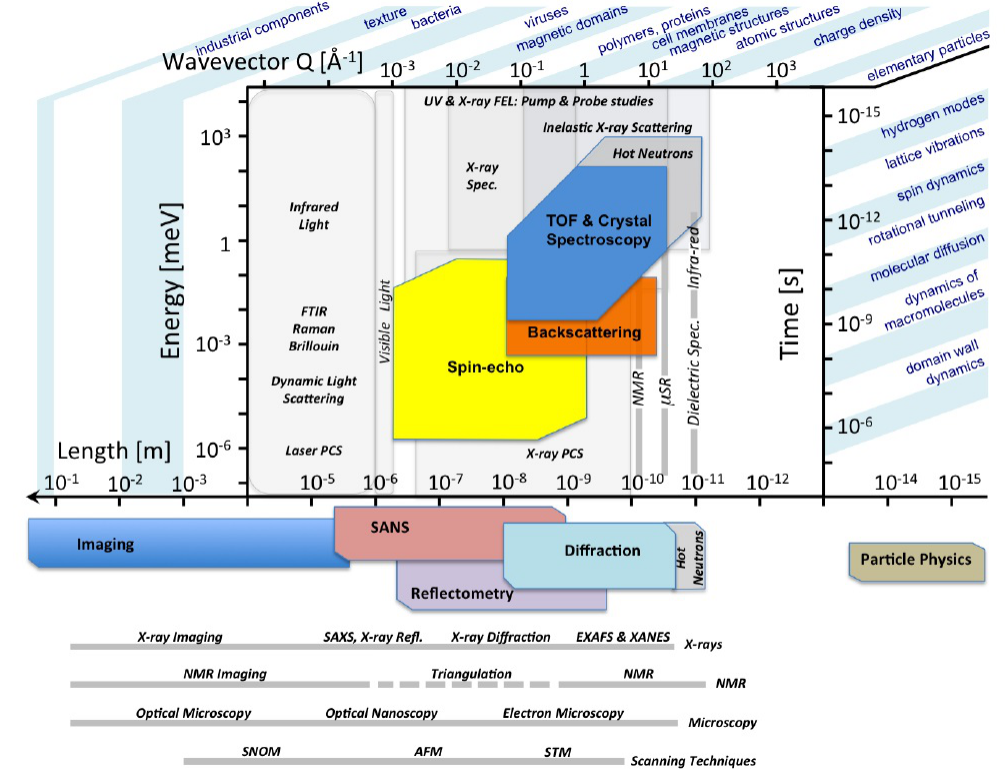
Figure 1. Regions of Q and E simultaneously accessible to neutrons, and qualitative comparison with other experimental probes. For ease of comparison, associated length and time scales are given by the bottom and right axes, respectively. Neutron spectroscopic techniques include the use of epithermal (hot neutrons), thermal (time-of-flight and crystal spectroscopy), and cold/ultracold wavelengths (backscattering and NSE). Blue text entries around the main figure illustrate areas of scientific and technological application. Reprinted with permission from Ref.